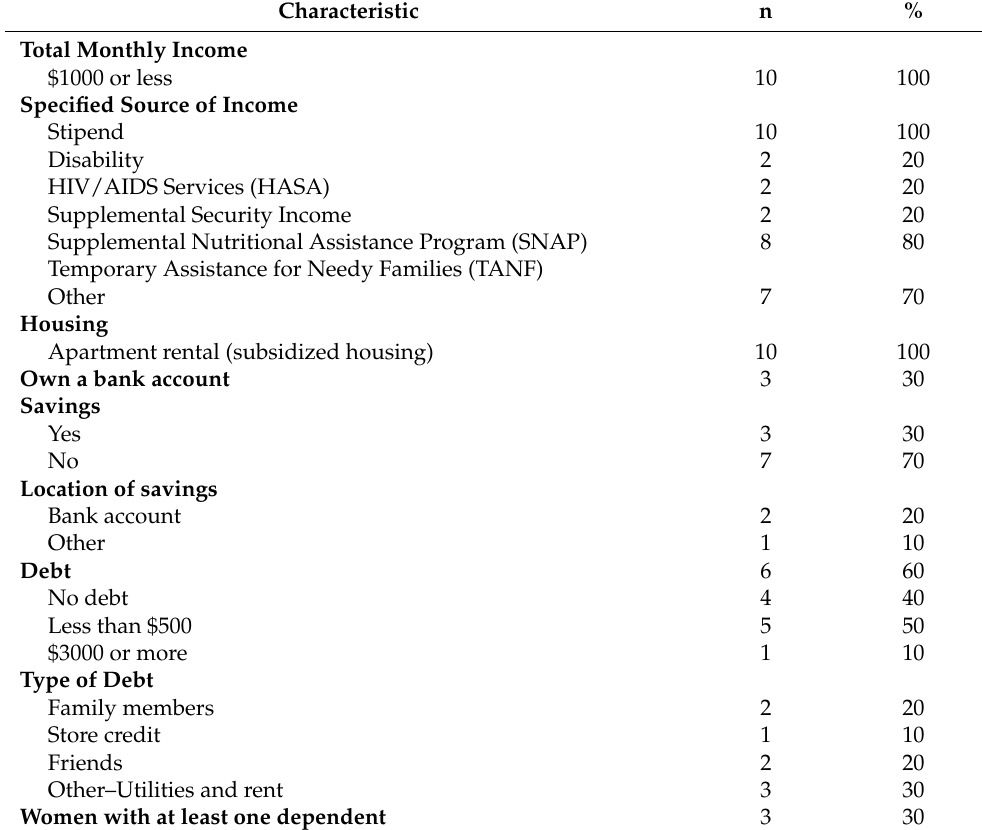
Table 5. Financial and household composition (N = 10).